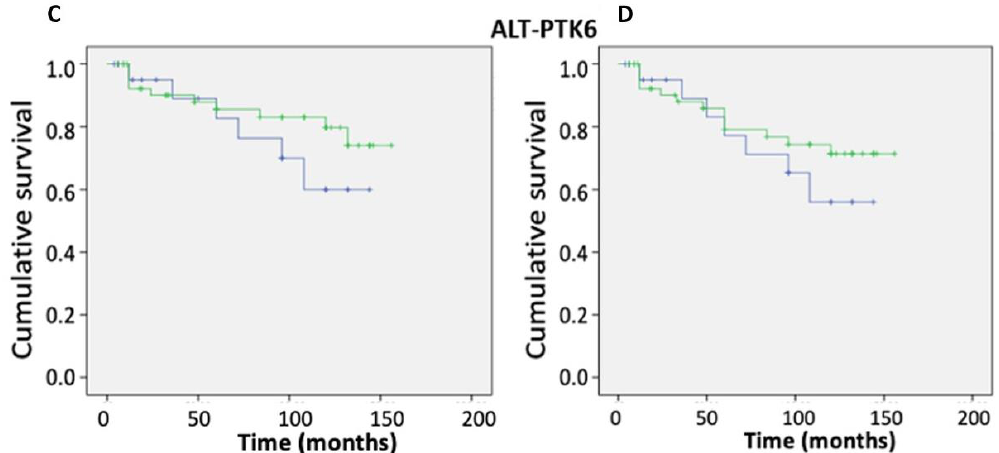
Figure 5. Effect of ptk6 transcripts on patient outcomes. Ptk6 transcript expression was determined in breast cancer tissue (n = 127) in relation to the normal background tissue (n = 33) using real-time qPCR and correlated with conventional clinic-pathological parameters and clinical outcomes. The Kaplan–Meier curves show high ptk6 expression (green) and low ptk6 (blue) levels in relation to ( A ) overall and ( B ) disease-free survival over time, as well as ALT-TPK6 in relation to ( C ) overall and ( D ) disease-free survival over time, where high expression is again in green and low expression is in blue. The statistical analysis is shown in the Supplemental Tables S1–S4.